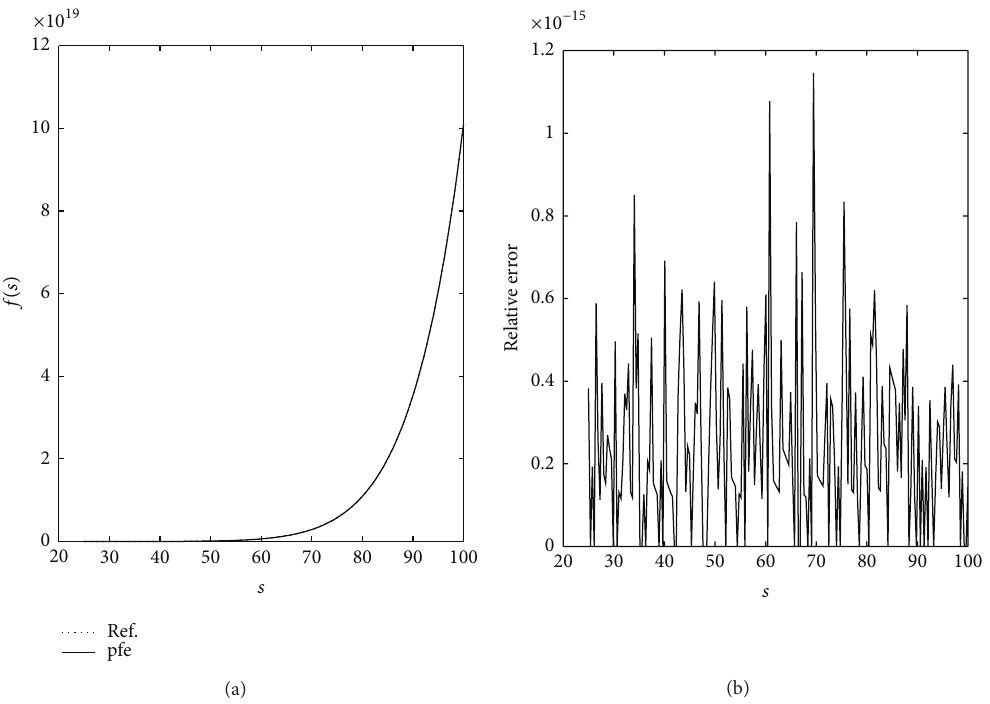
Figure 1: Comparison of pfe with reference solution (a) and relative error of pfe (b) in Example 2. Residual polynomial coefficients are calculated using the method proposed in Section